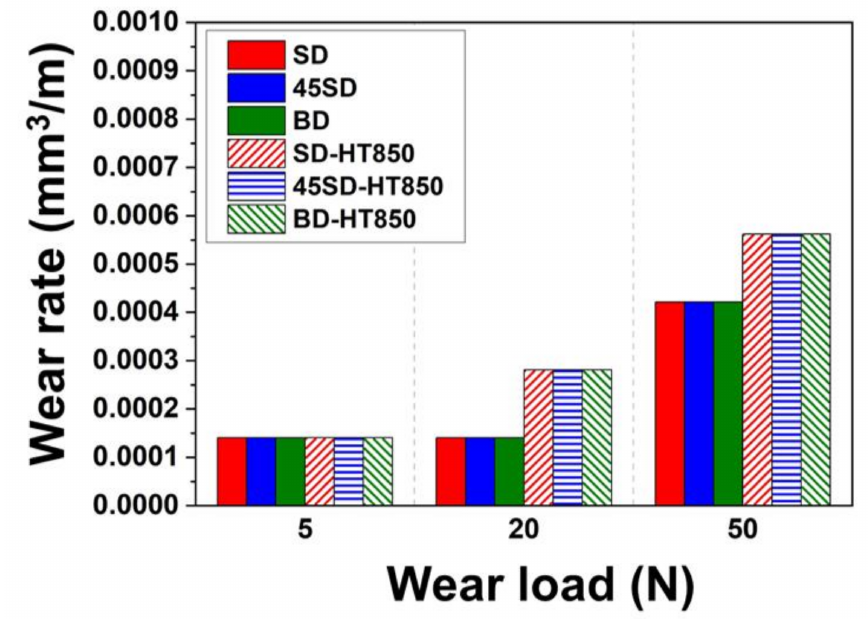
Figure 6. Comparison of the wear rate of AISI 52100 steel counterpart